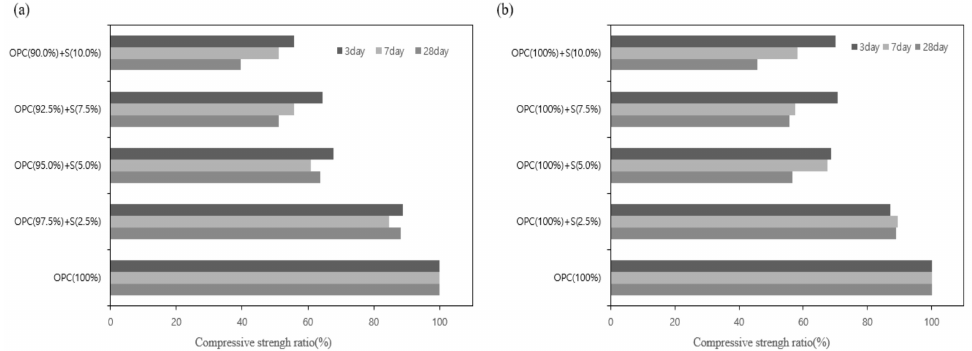
Figure 5. Relative comparison of the compressive strength ratios for binder ( a ), aggregate ( b ) by OPC (100%). The figure shows that, as the mixing ratio of bio-sulfur increased, the compressive strength decreased, and the binder had lower compressive strength than the